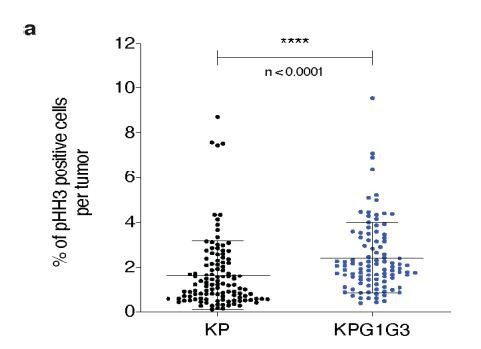
KPG1G3 tumors proliferate significantly more than KP lesions.(a) Dot plot with mean ± s.d shows percent of pHH3 positive cells per KP or KPG1G3 tumors (n = 4, 6 mice and n = 115, 101 tumors, respectively) at sacrifice. ****: p < 0.0001 by Mann-Whitney test.